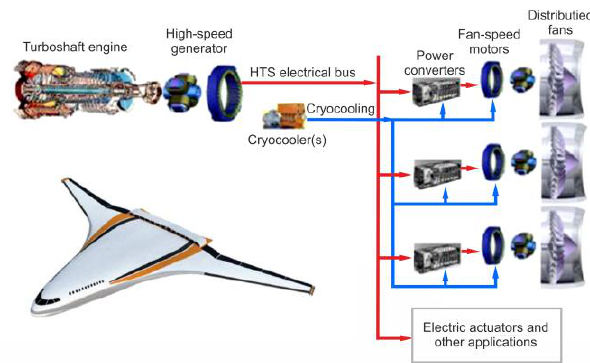
Fig. 1. Airplane in a flying wing configuration with a hybrid, distributed propulsion